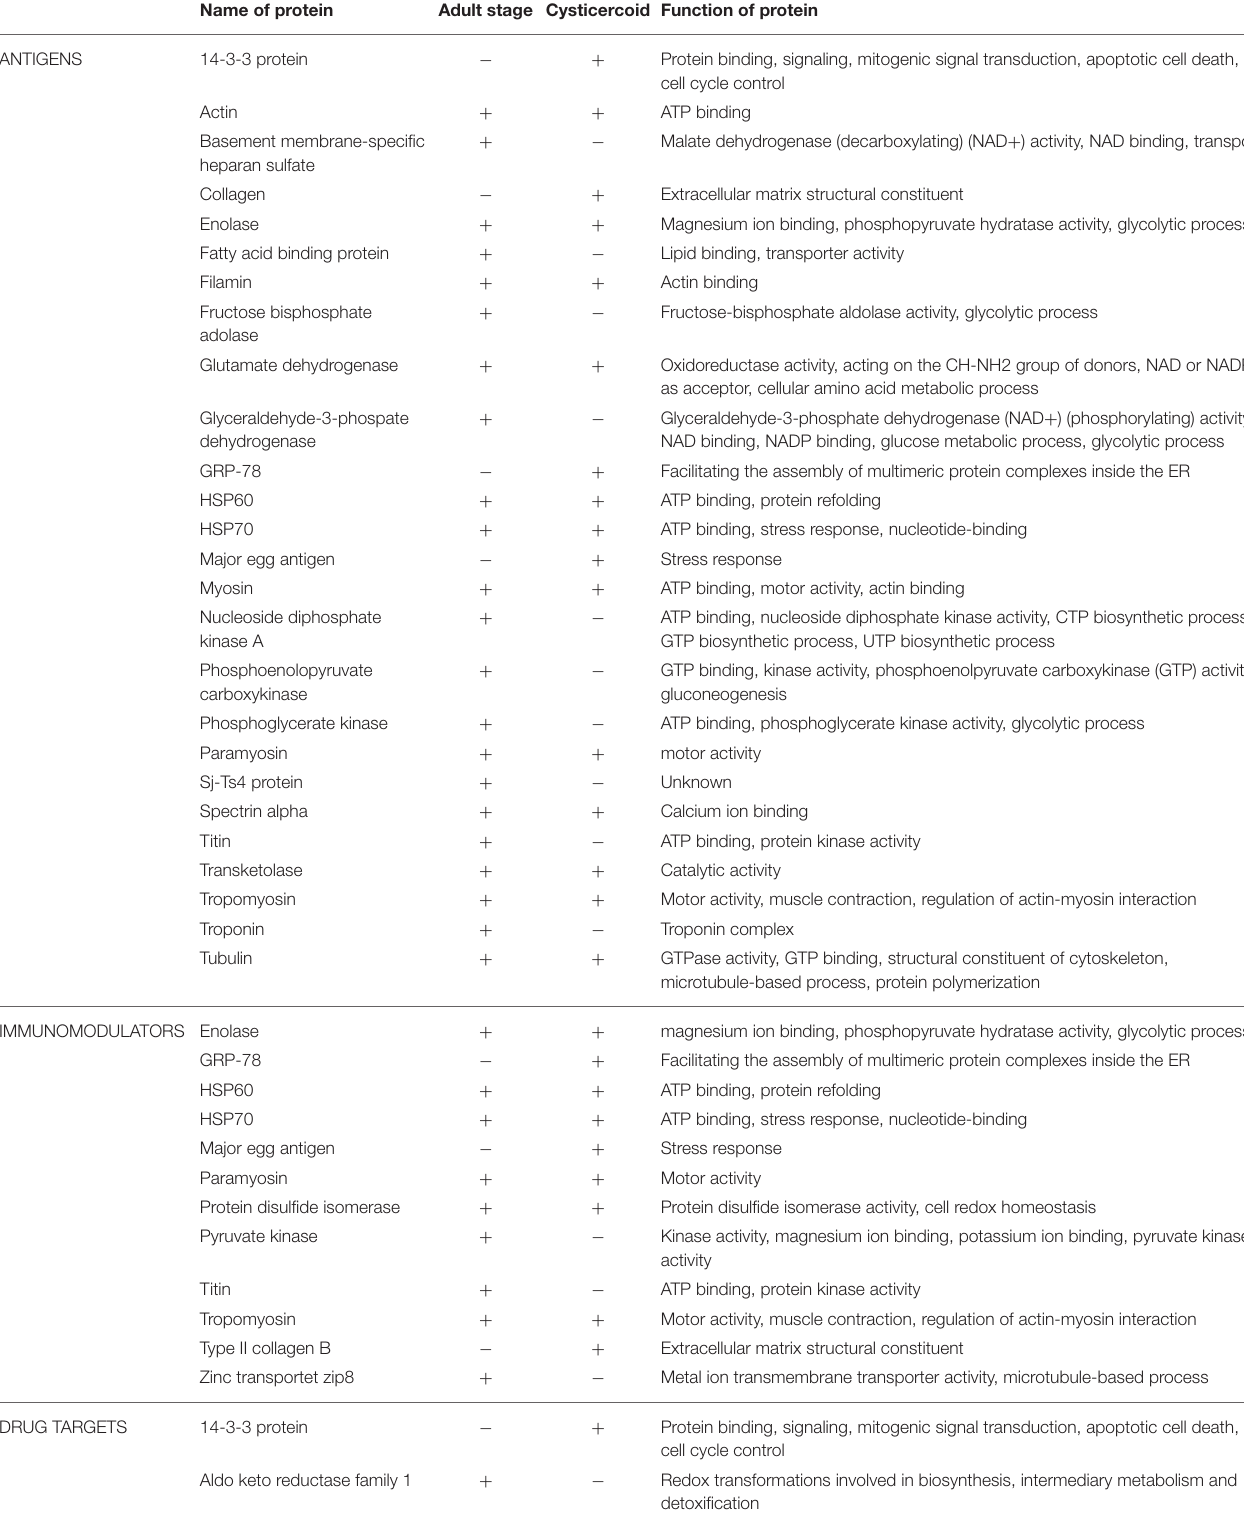
TABLE 1 | The division of cysticercoid and adult stage proteins into three subgroups: antigens, immunomodulators and drug targets, on the basis of the available literature. Name of